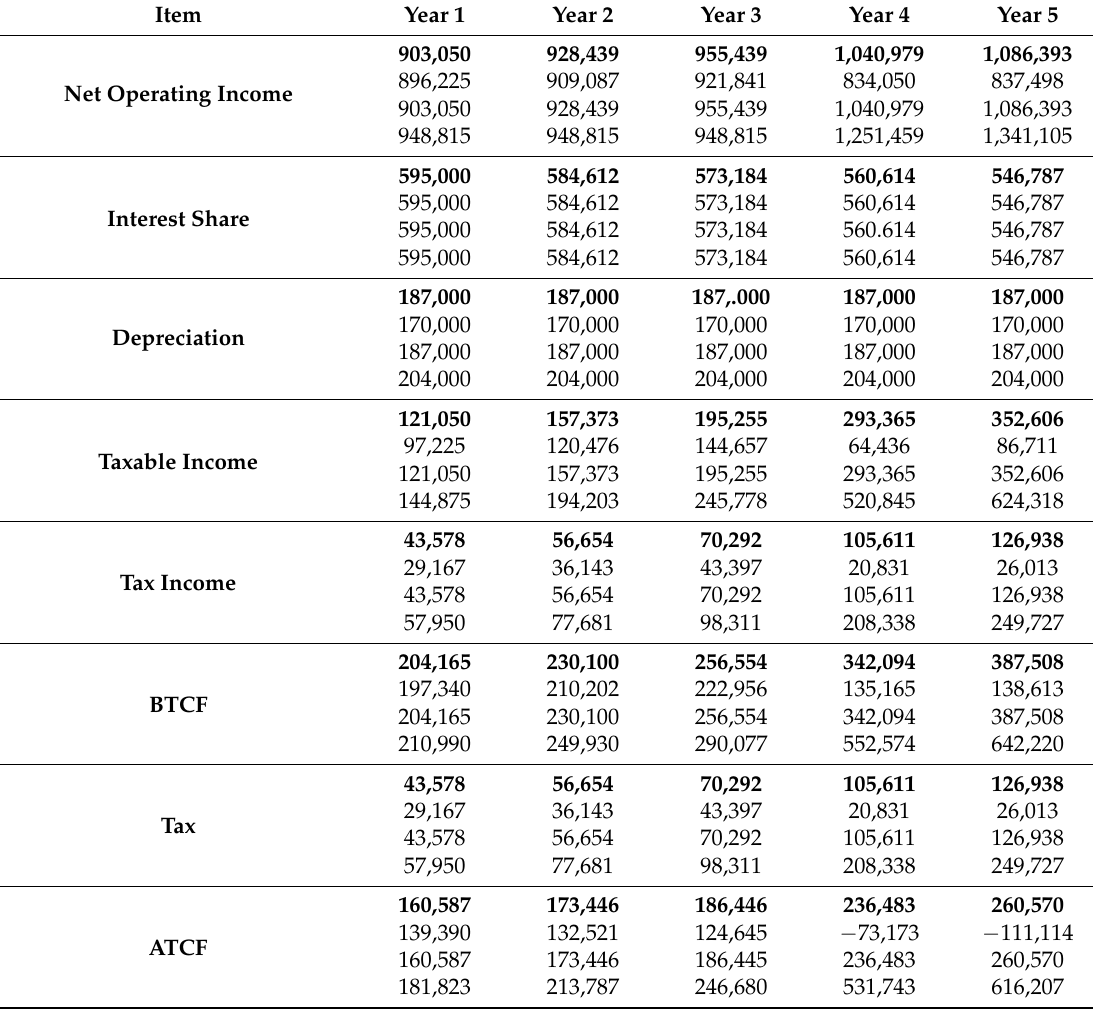
Table 11. Calculation of After Tax Cash